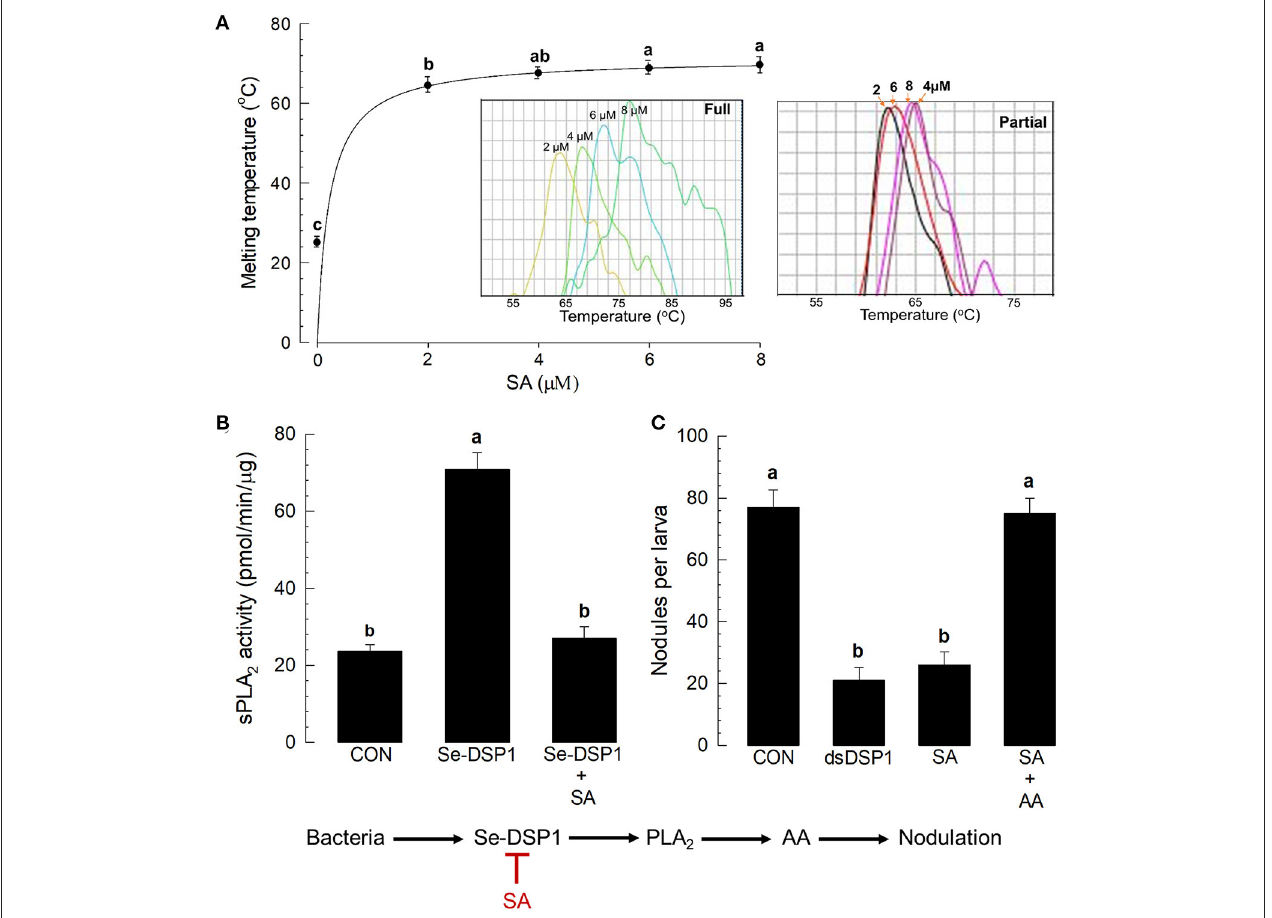
FIGURE 6 | Salicylic acid binding to Se-DSP1 and the suppression of immune mediation. (A) The binding affinity of SA to Se-DSP1 by a thermal shifting assay (inset figures of full and partial Se-DSP1). (B) The suppression of sPLA 2 activity induced by Se-DSP1 (1 µ g/larva). The enzyme activity in the fat body was measured 8h after the injection. SA was injected to the L5 larvae at a dose of 10 µ g per larva. Control (“CON”) represented the PBS injection. (C) The rescue of SA-suppressed nodulation by the addition of AA (10 µ g per larva). For the nodulation assay, HK E. coli were injected at a dose of 4.5 × 10 4 cells per larva. At 8h after the bacterial injection, nodule formation was assessed. Each treatment was replicated three times. Different letters above SD bars indicate a significant difference among means at Type I error = 0.05 (LSD test).